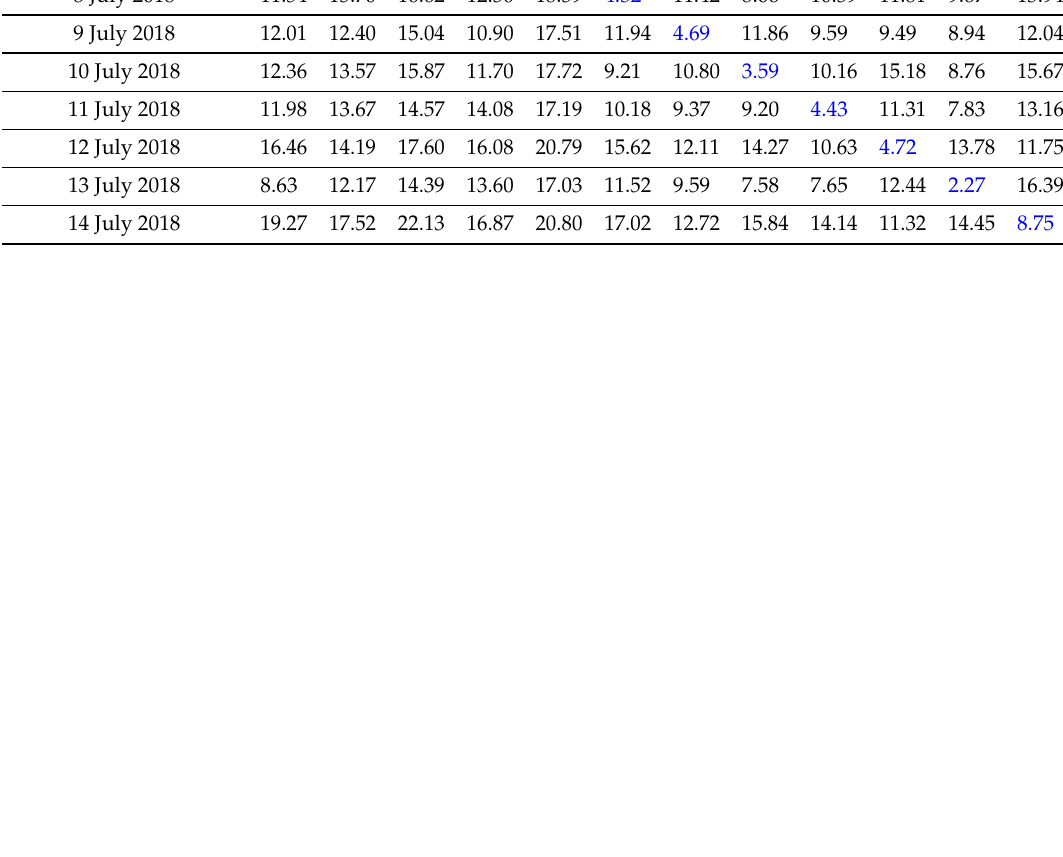
is DPIV; C ∗ is MOG2/ResNet32; C ∗ is 2 3 1